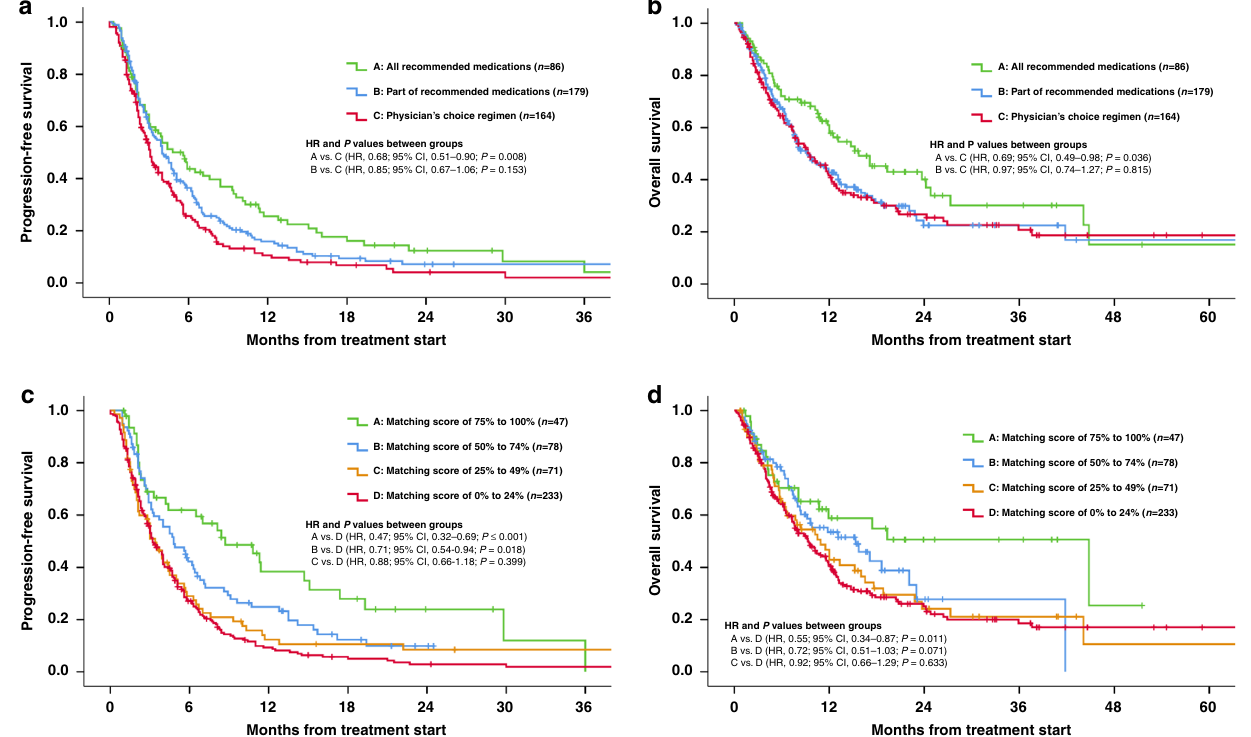
Fig. 2 Progression-free survival and overall survival according to compliance with recommendation of Molecular Tumor Board and matching scores. a Progression-free survival according to compliance with recommendation of the Molecular Tumor Board ( N = 429). Progression-free survival was signi fi cantly longer when Molecular Tumor Board recommendations were followed in full (group A) when compared to patients who received physician choice regimen (group C) (A vs. C: HR, 0.68; 95% CI, 0.51 – 0.90; P = 0.008, A vs. B: HR, 0.80; 95% CI, 0.60 – 1.06; P = 0.122, B vs. C: HR, 0.85; 95%